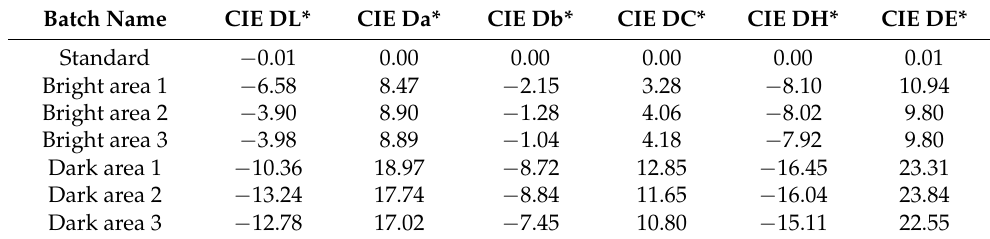
Table 2. CIELAB coefficients of MZH mortar cement.